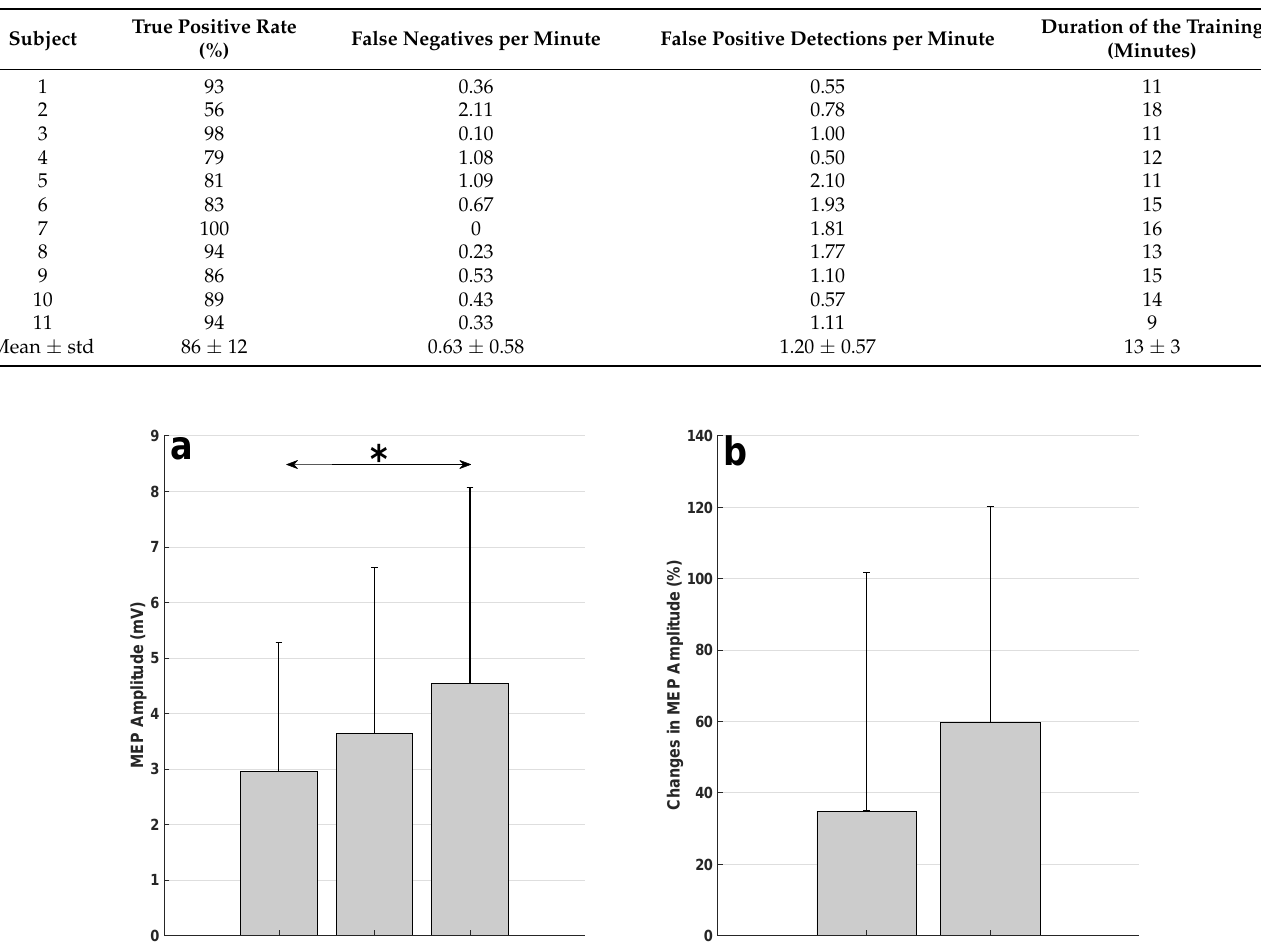
Table 1. Brain-computer interface performance.